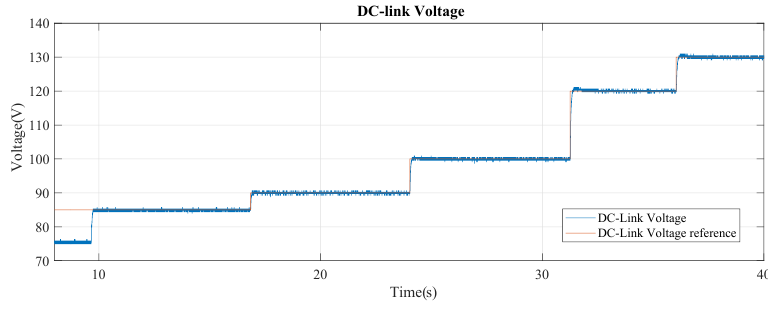
Figure 10. Variable DC link voltage reference test.